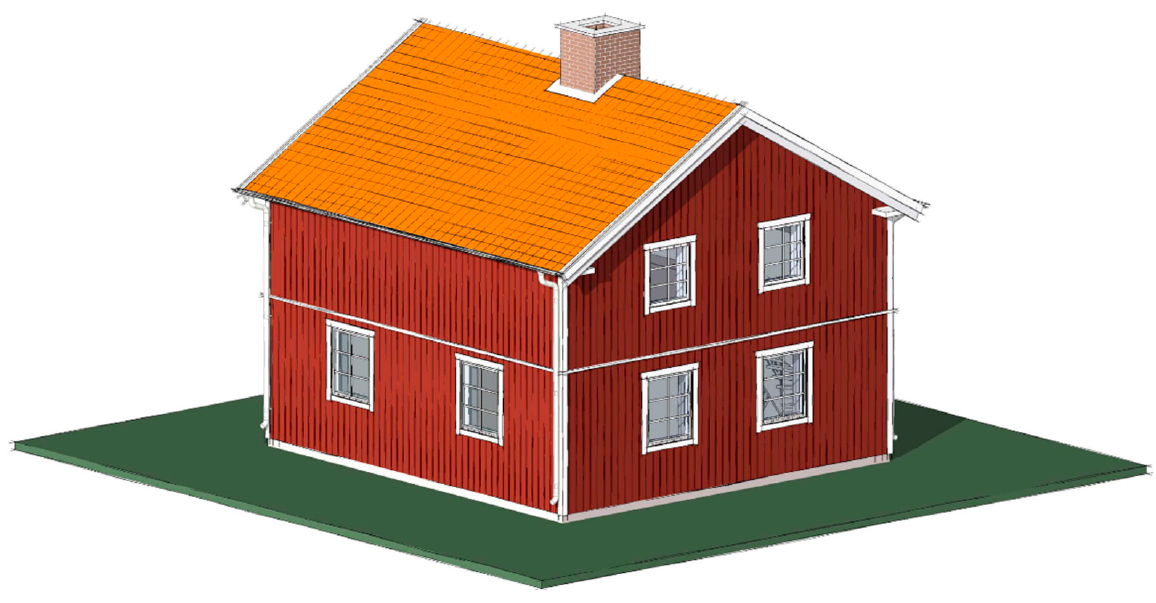
Figure 1. Prototype model for calculation of facade area.